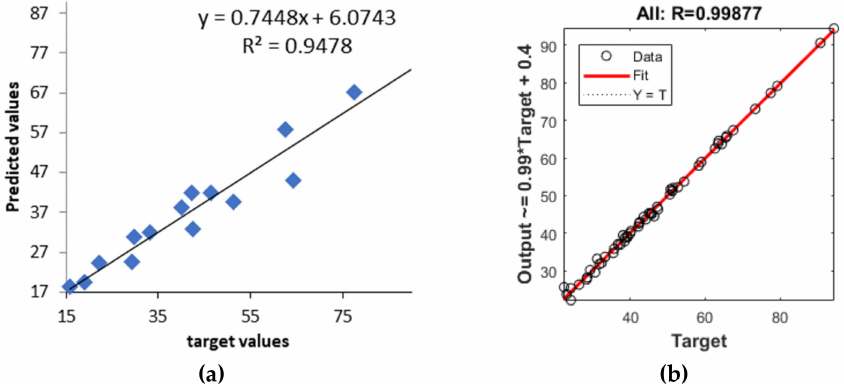
Figure 6. Predicted and experimental cumulative % of ibuprofen release ( a ) for the test dataset in neural network 1 and ( b ) for the whole dataset (training, validation, and test) in neural network